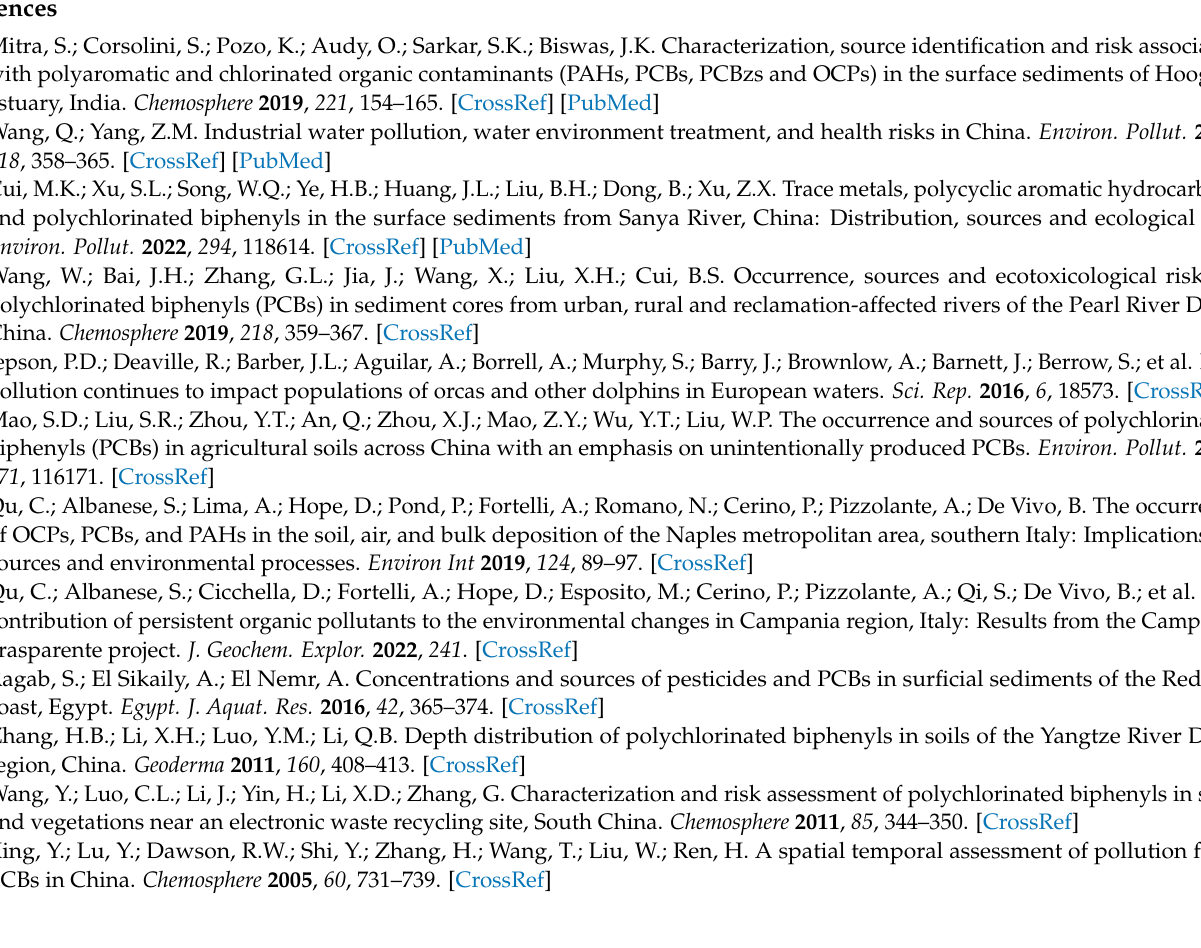
Table S3: The homolog groups of detected PCBs; Table S4: The PNECs values corresponding to the concentrations of individual PCBs (ng L − 1